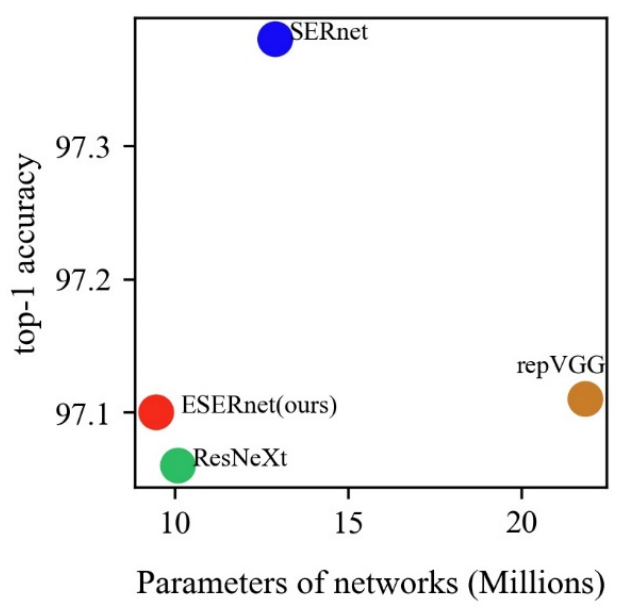
Figure 8. Average accuracy and number of parameters for different models. Table 2. Average Running Time of Different Models.